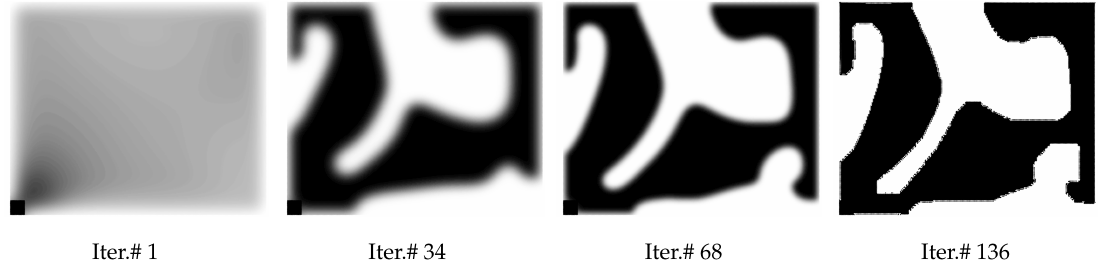
Figure 2. Development of the physical design of the reference antenna over iterations 1, 34, 68, and 136. Black color indicates a good conductor and white color indicates a good dielectric.